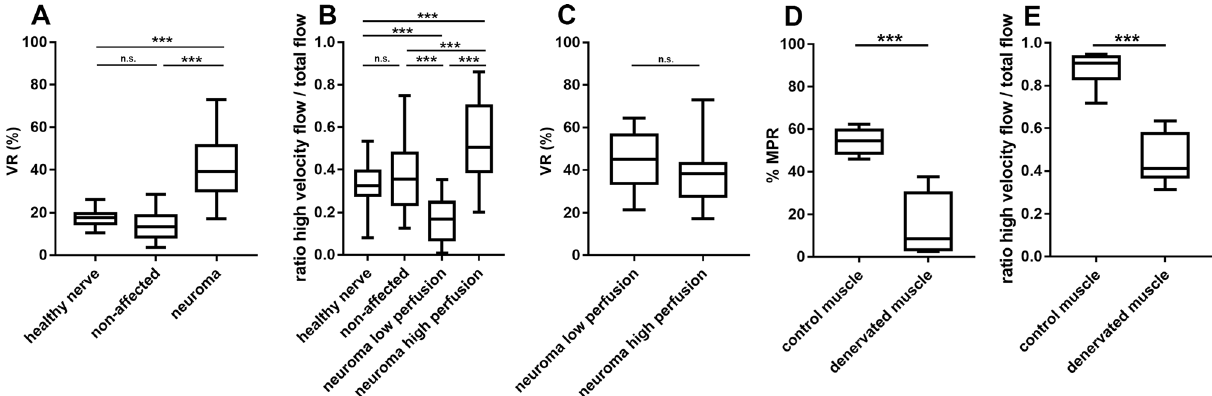
Figure 6. Assessment of VRs and MPRs for intact versus injured nerve and muscle. ( A ) The VRs determined for the neuromas are significantly increased, while the VRs for the healthy nerves and the patients’ unaffected nerve portions show no significant difference. ( B ) The proportion of high velocity blood flow is significantly reduced in the group of low perfusion neuromas, while it is significantly increased in the high perfusion neuromas when compared to the healthy nerve and non-affected nerve portions. Although the rate of high velocity blood flow differs in the high- and low perfusion neuromas, the VRs of both groups do not differ ( C ). The MPRs determined for the denervated muscle are significantly decreased compared to the intact contralateral control muscles ( D ). Moreover, the portion of high velocity blood flow is significantly decreased in the denervated muscle compared to the control ( E ). ( A , B ) 1-way ANOVA with Tukey multiple comparison test; ( C ) unpaired t-test; ( D , E ) Mann–Whitney